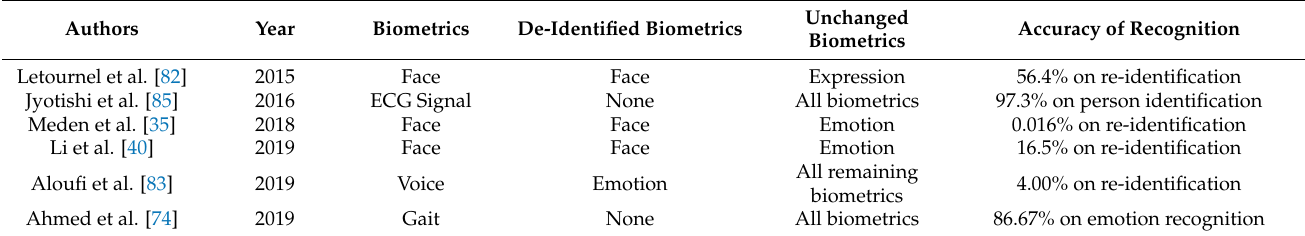
Table 6. Summary of emotion-based identification and de-identification